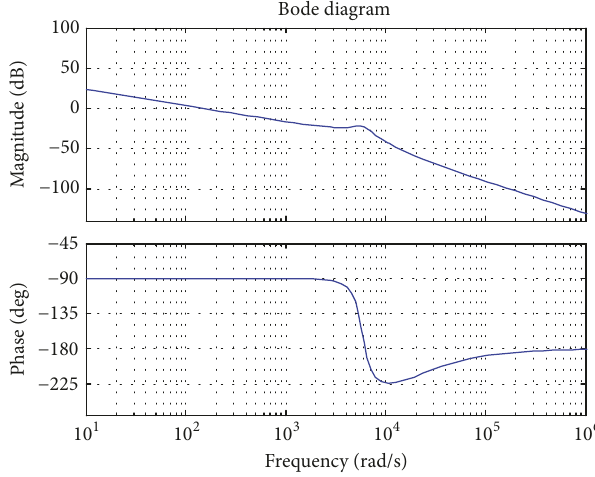
Figure 1: Bode plot of designed